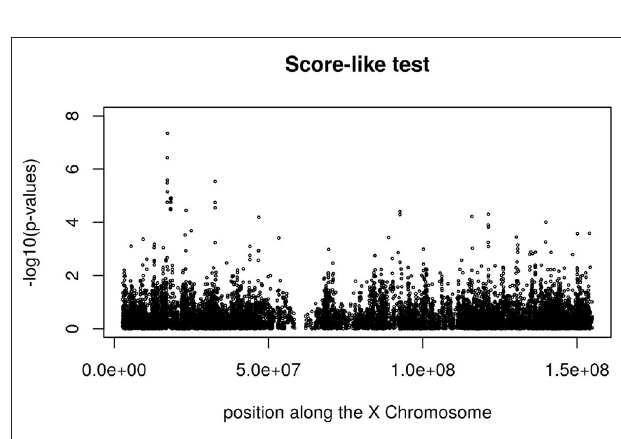
FIGURE 3 | Manhattan plot of X Chromosome genome-wide association results-Score-like